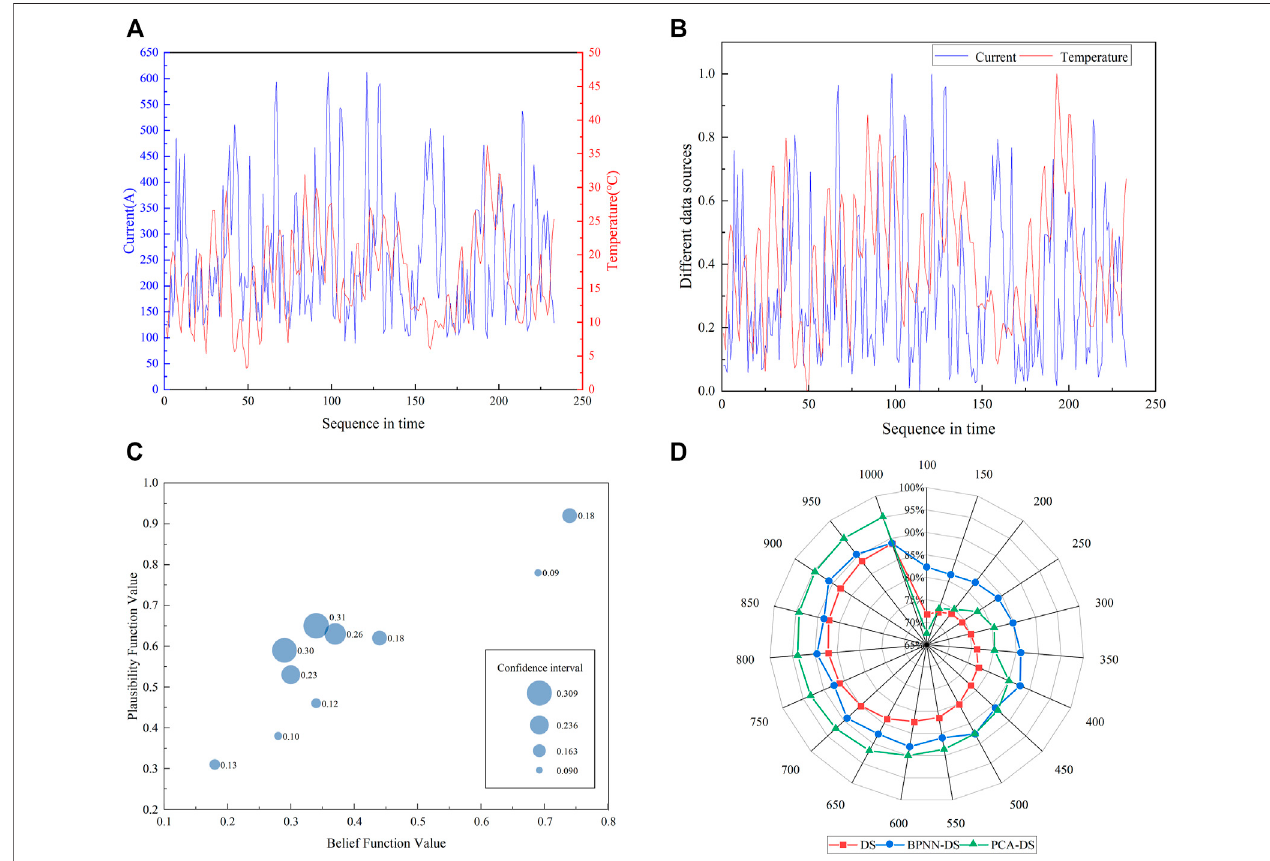
FIGURE 3 | (A) Results before multi-source data processing. (B) Results after multi-source data processing. (C) Change of con fi dence interval during data fusion. (D) Comparison of the accuracy of the results of the three algorithms in the later diagnosis analysis.